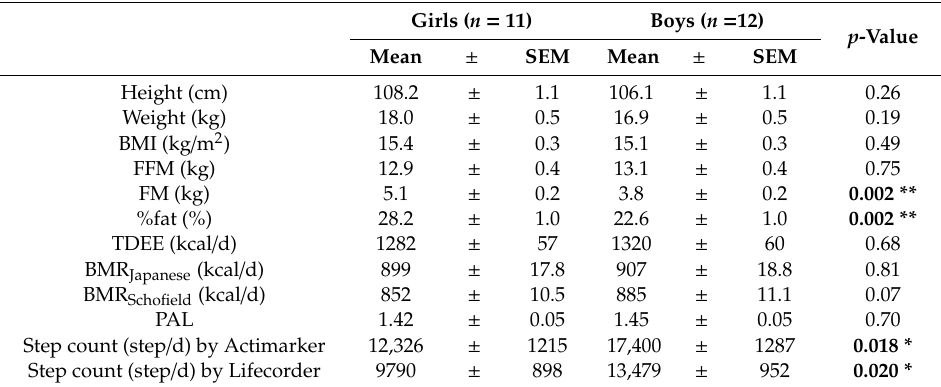
Table 2. Comparison between girls and boys using ANCOVA adjusted for